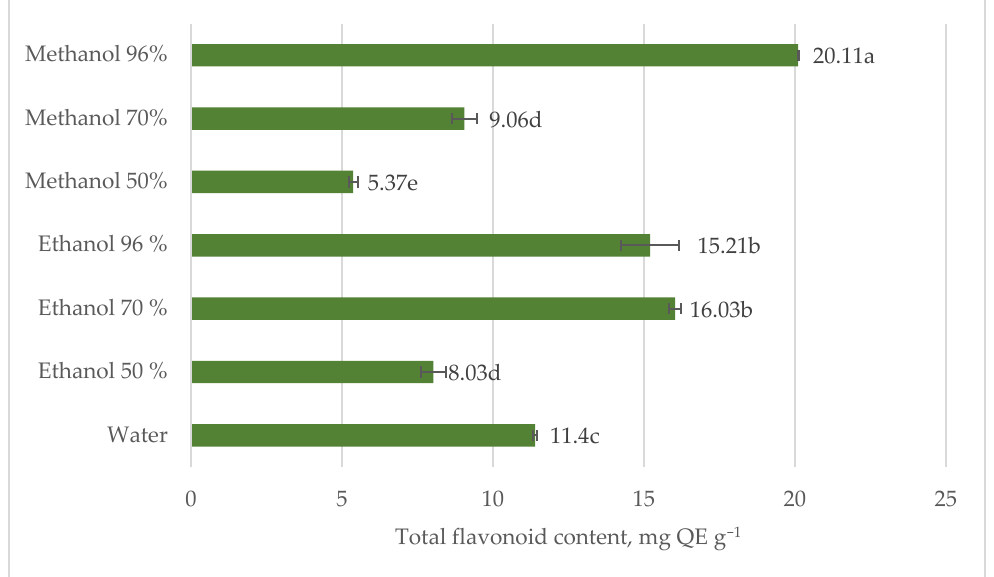
Figure 3. Total flavonoid content in stinging nettle ( Urtica dioica L.) leaves extracts, mg QE g − 1 DM .